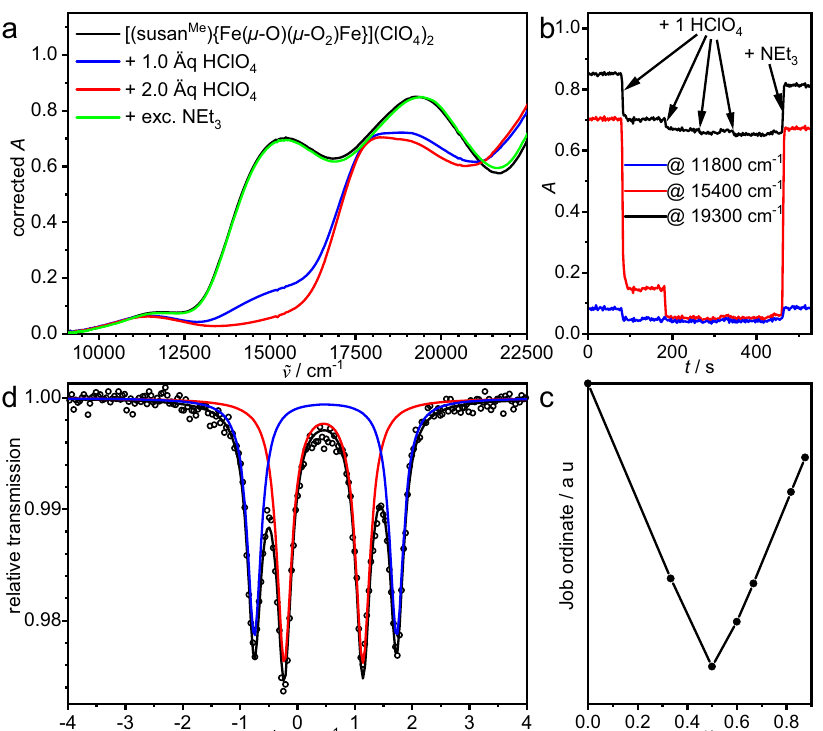
Fig. 6 Protonation of [(susan 6-Me ){Fe III ( μ -O)( μ -1,2-O 2 )Fe III }] 2 + and spectroscopic characterization of the protonated complex [(susan 6-Me ){Fe III ( μ - O)( μ -1,2-OOH)Fe III }] 3 + . a UV-Vis spectroscopic characterization of protonation and deprotonation of [(susan 6-Me ){Fe III ( μ -O)( μ -1,2-O 2 )Fe III }] 2 + in CH 3 CN/CH 2 Cl 2 (1:2) at − 60 °C ( c = 0.77 mM). b Selected time traces for the protonation/deprotonation in a . c Job-plot analysis at 15,400cm − 1 of the protonation in a . d 57 Fe Mössbauer spectrum of a frozen solution of [(susan 6-Me ){Fe III ( μ -O)( μ -1,2-OOH)Fe III }] 3 + at 80 K generated by treating Table